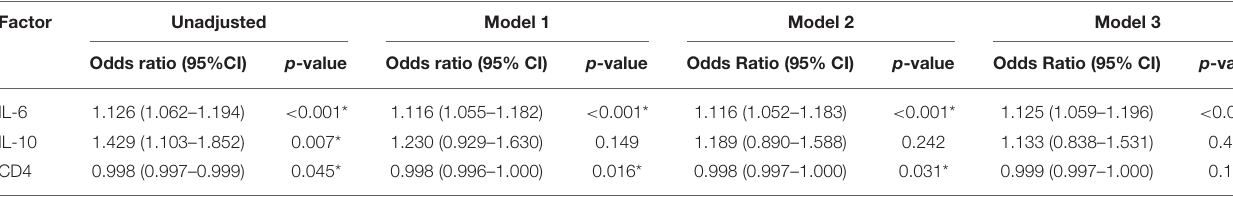
Factor Unadjusted Model 1 Model 2 Model